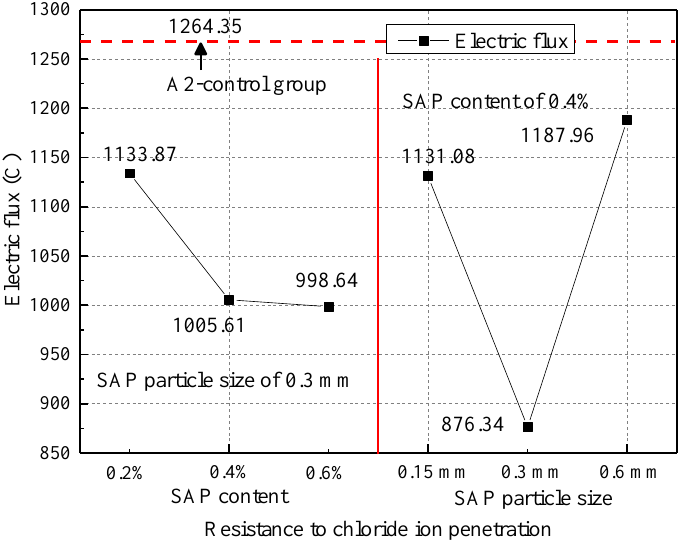
Figure 15. The influence of SAP on the ability of concrete to resist chloride ions.